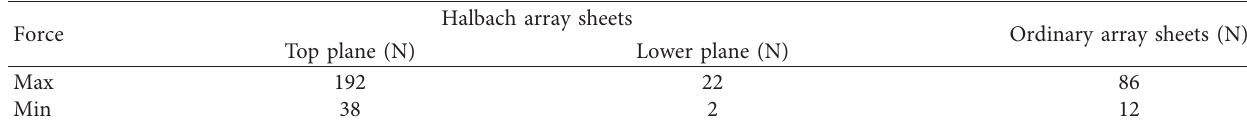
Figure 10: The force contrast of two magnetic arrays on wall surfaces. (a) Force diagram of Halbach array sheets; (b) force diagram of ordinary array sheets. Table 1: Force data of Halbach array and ordinary array sheets.